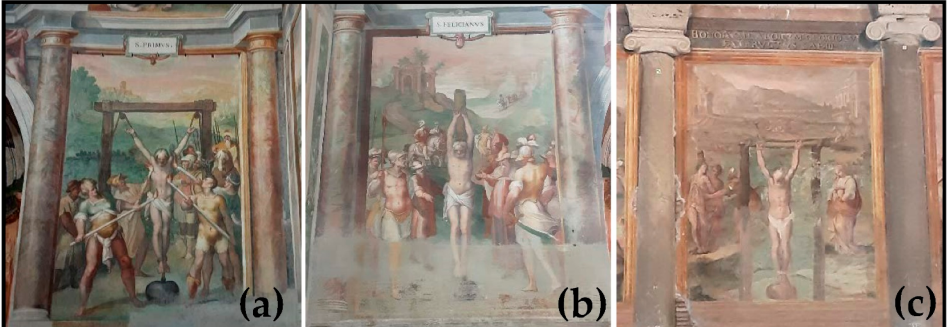
Figure 4. Indoor frescos inside the Basilica of Santo Stefano Rotondo, Rome (Antonio Tempesta, Pomarancio and Matteo da Siena, 1586) representing the martyrdom of: San Primus ( a ); San Felicianus ( b ); a nameless martyr ( c ). Primus and Felicianus brothers suffered martyrdom around the year 297 AD, during the Diocletian persecution. The relatively bad quality of photos ( b , c ) is because the frescos are not well